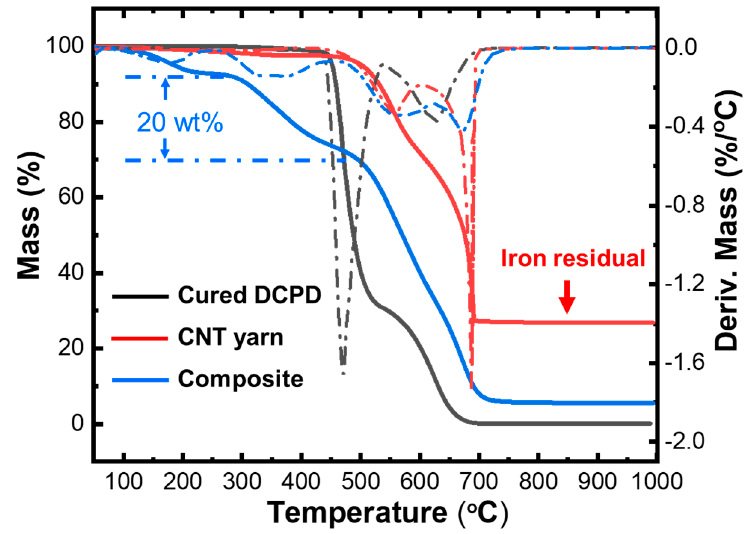
Figure 6. Thermogravimetric analysis (TGA) characterization of cured DCPD, CNT yarn and DCPD-CNT composite yarn. The dotted curves are derivative weights of the corresponding samples.